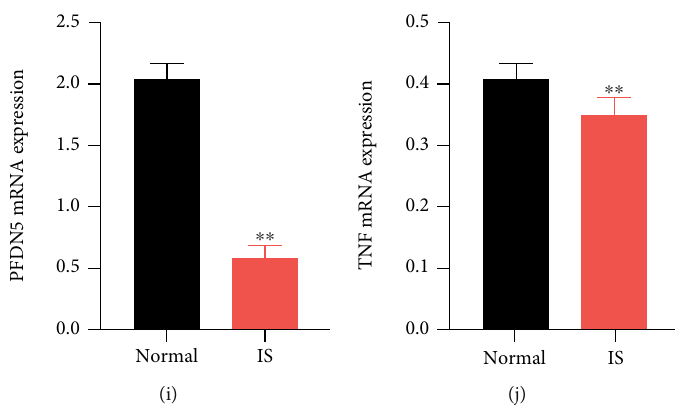
Figure 8: Validation of the hub genes by qRT-PCR. Black, normal samples; red, IS samples. ∗∗ means p -value < 0.01, and #means no di ff erence. All data correspond to the average ± SEM. Statistical signi fi cance was assessed by the two-tailed Student ’ s t